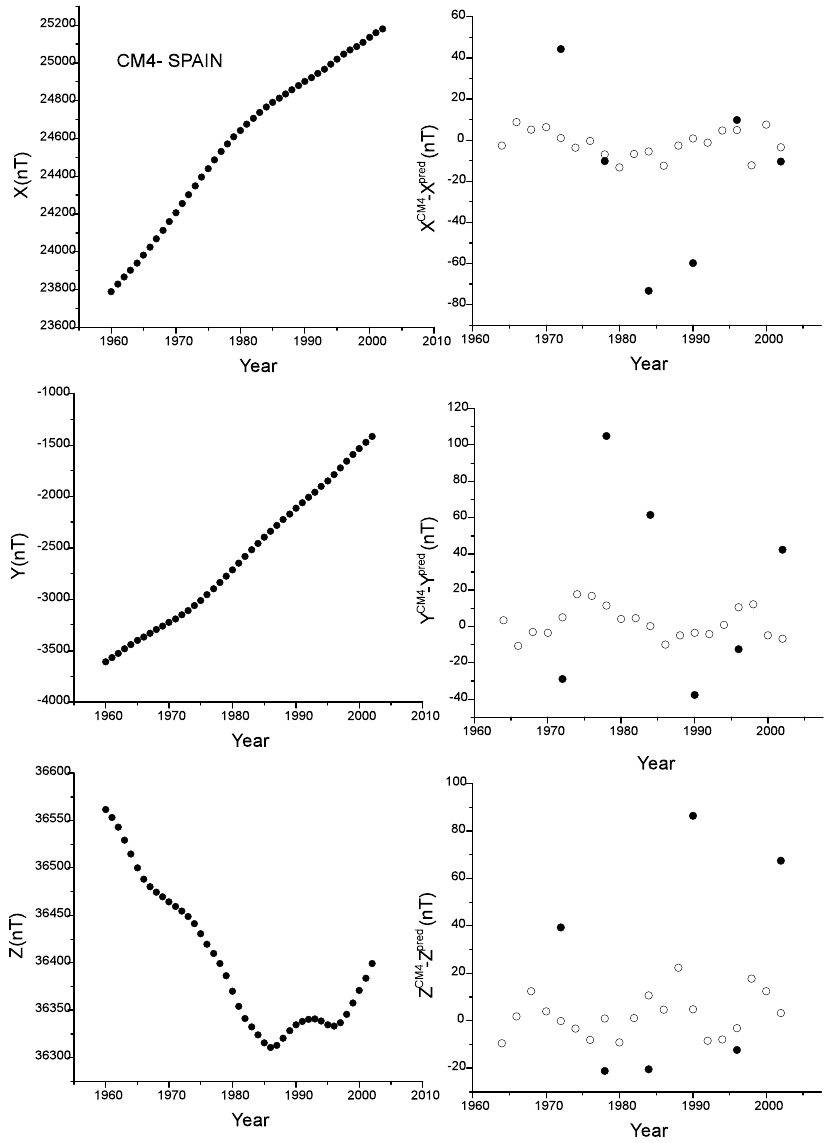
Figure 4. Left: Synthetic case of possible repeat-station time series of the geomagnetic component in a central point in Spain, as deduced from the CM4 model. Right: Differences between the synthetic (actual) values and the predicted values when the frequency of repetition is one data point every 2 years (white circles) and 6 years (black